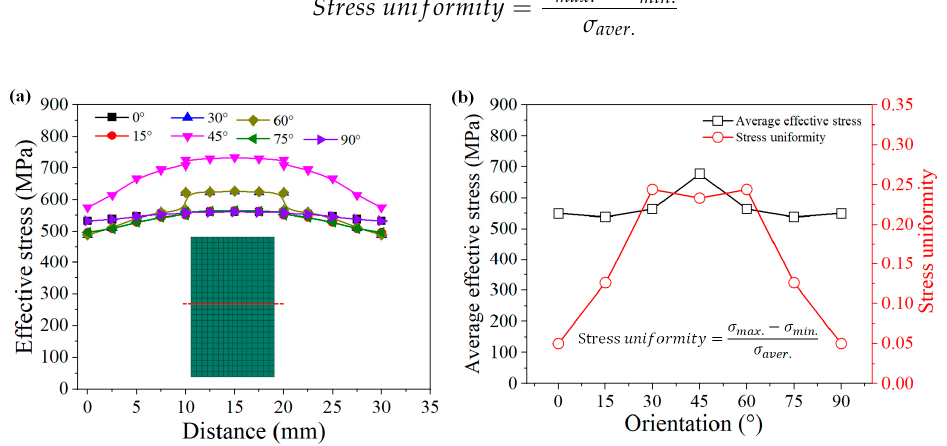
Figure 6. Stress distribution along red trace line for different grain orientations: ( a ) stress distribution curves; ( b ) average effective stress and stress uniformity.